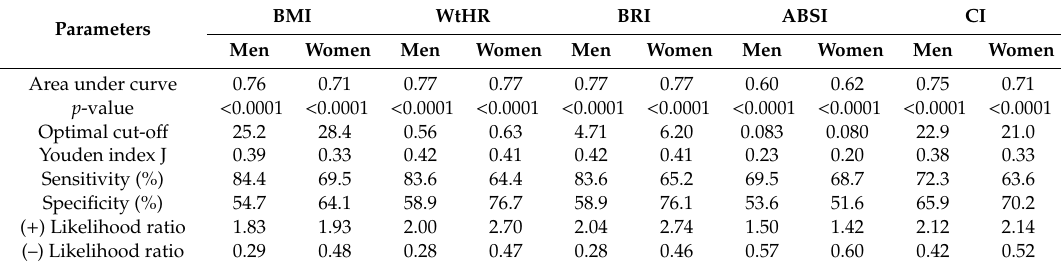
Table 2. Cut-off points, area under curve, sensitivity and specificity for BMI, WtHR, BRI, ABSI, and CI to detect high cardiometabolic risk (CMRI ≥ 1 SD) by sex.